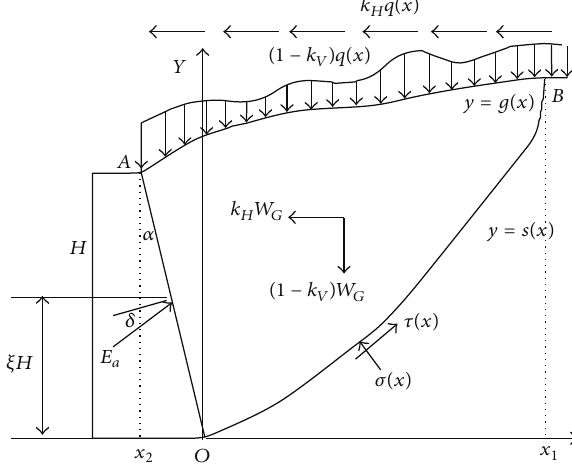
Figure 1: Calculation model of seismic active earth